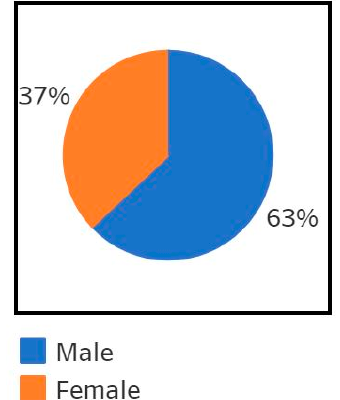
Figure 7. Proportions of vehicle-related flood fatalities by gender.